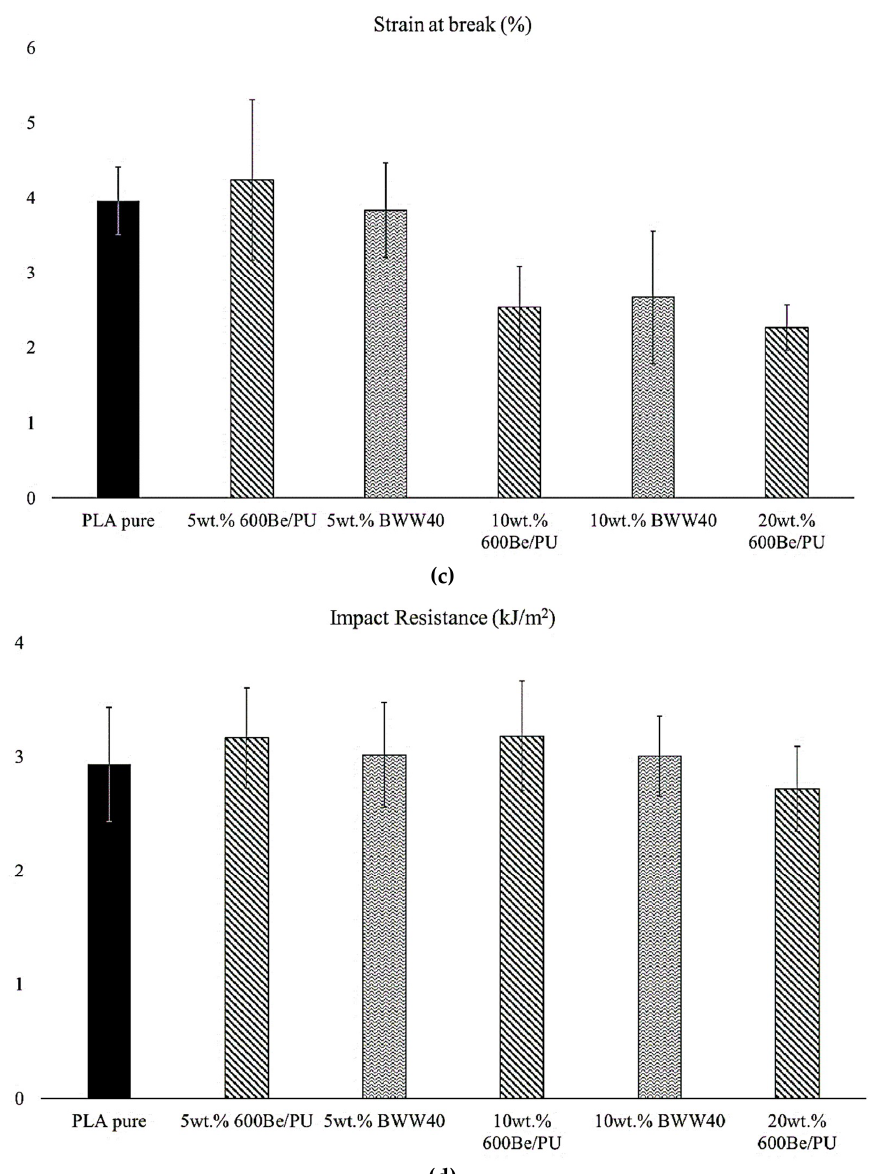
Figure 2. Mechanical properties of poly(lactic acid) (PLA)–Arbocel ® composites: ( a ) Young’s modulus, ( b ) stress at break, ( c ) strain at break, and ( d ) impact resistance.